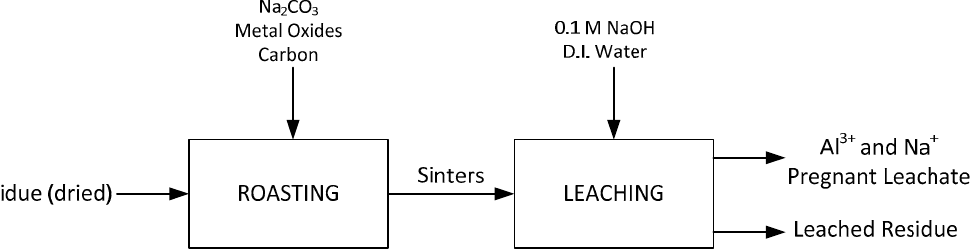
Figure 21. Results of experimental recovery of Al 2 O 3 , SiO 2 , and Na 2 O with CaO, MgO and BaO added